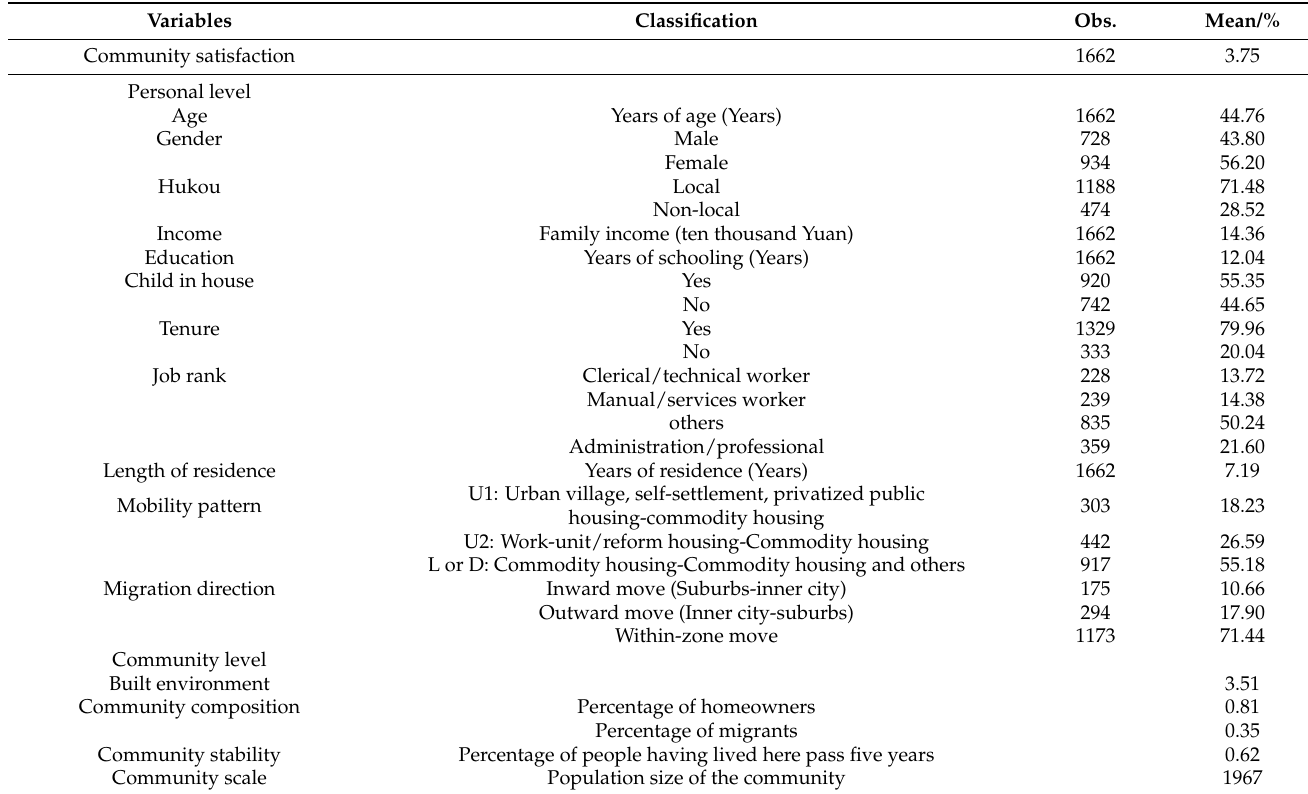
Table 1. Descriptive analysis of dependent and independent variables ( n =